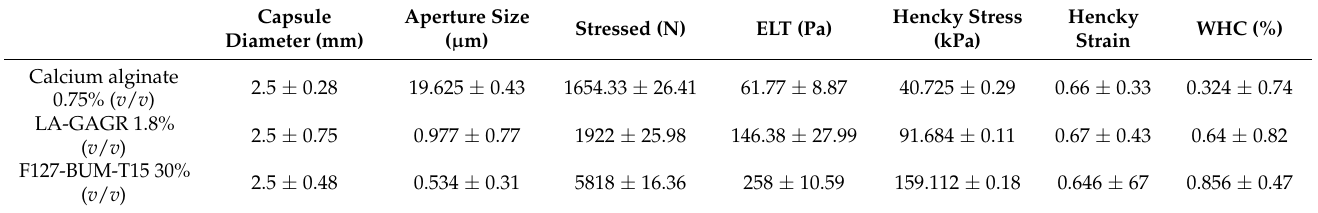
Table 1. The microscopic lattice structure and mechanical strength of Calcium alginate, LA-GAGR and